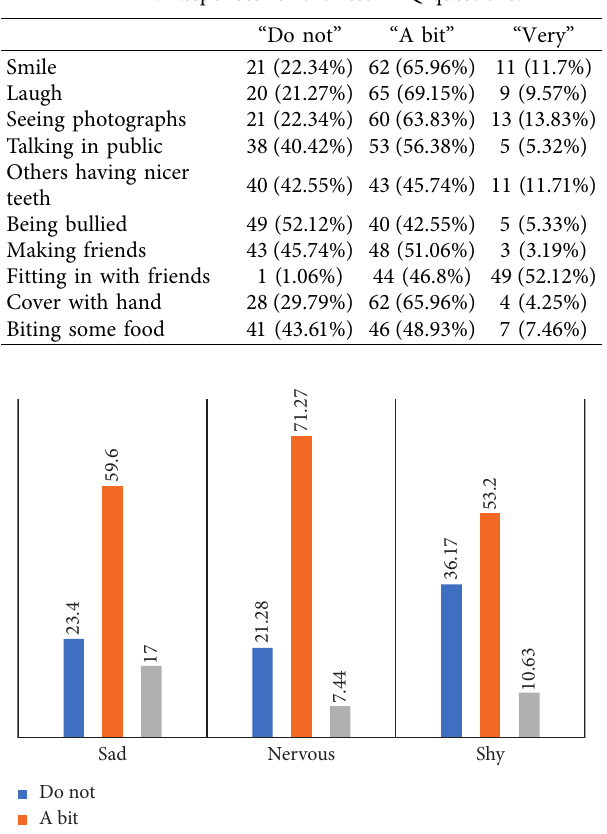
Table 4: Responses for the rest MIQ questions.